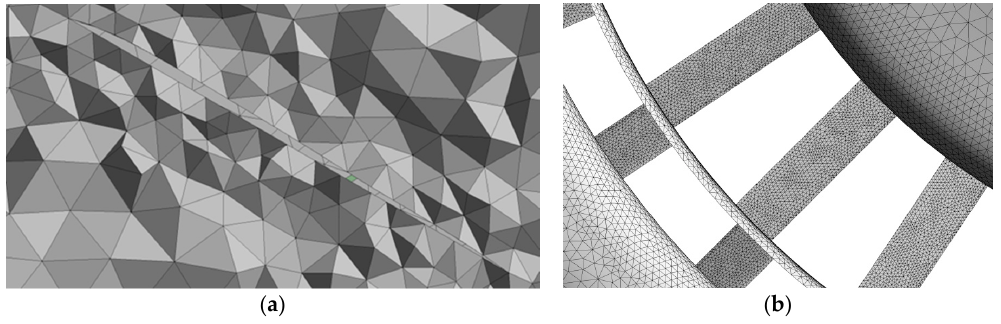
Figure 4. ( a ) Cross section mesh in the duct to show the geometry of blades; ( b ) Surface mesh of the aircraft.